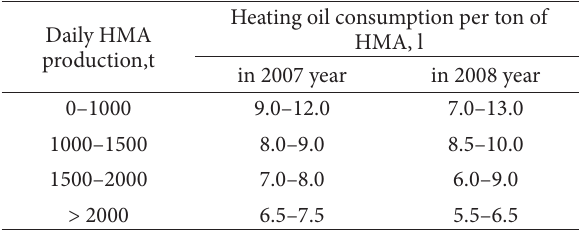
Table 2 . Heating oil consumption in AMP Benninghoven depending on daily HMA production Daily HMA